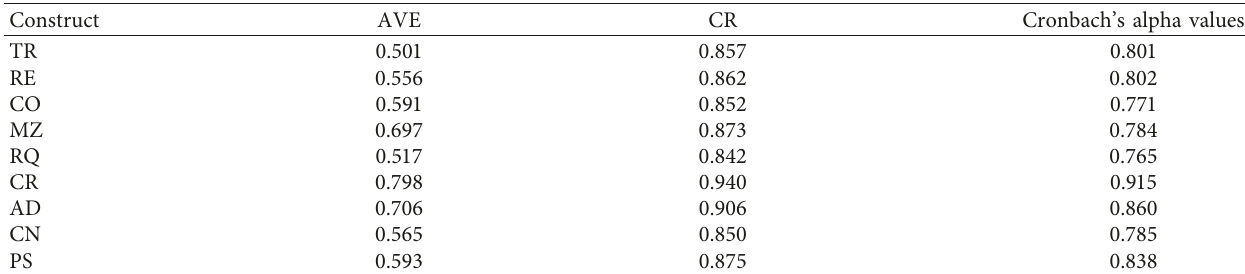
Table 3: Measurement reliability and convergent validity